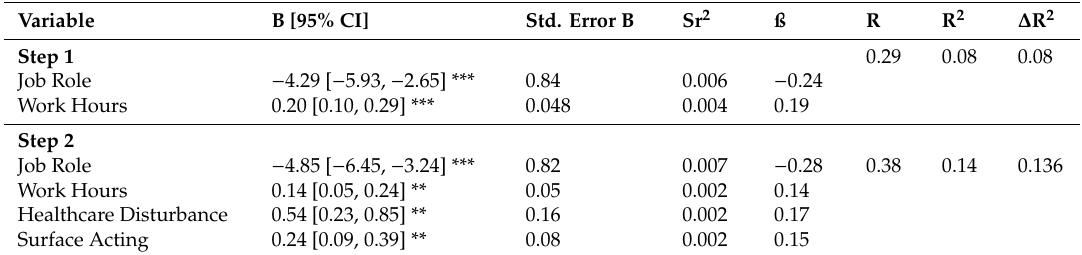
Table 3. Summary of hierarchical regression analysis for variables predicting depressive